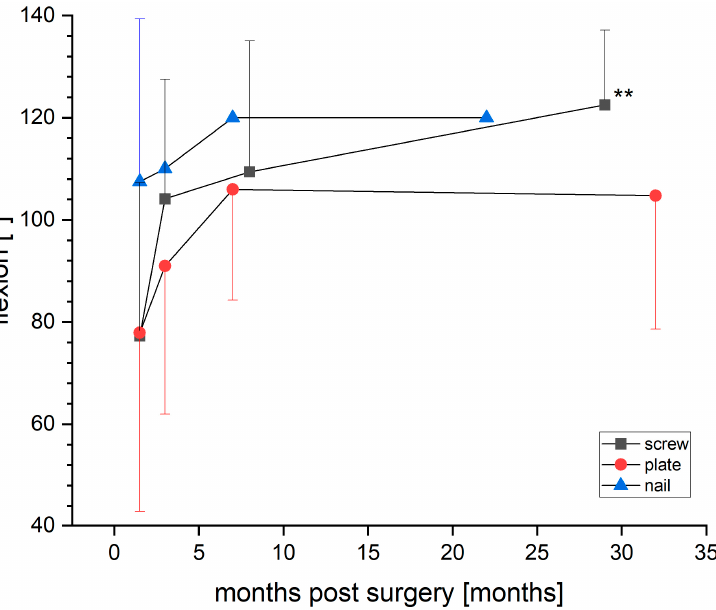
Figure 4. Flexion parameters and outcomes in comparison between groups. ** p = 0.009 vs. plate